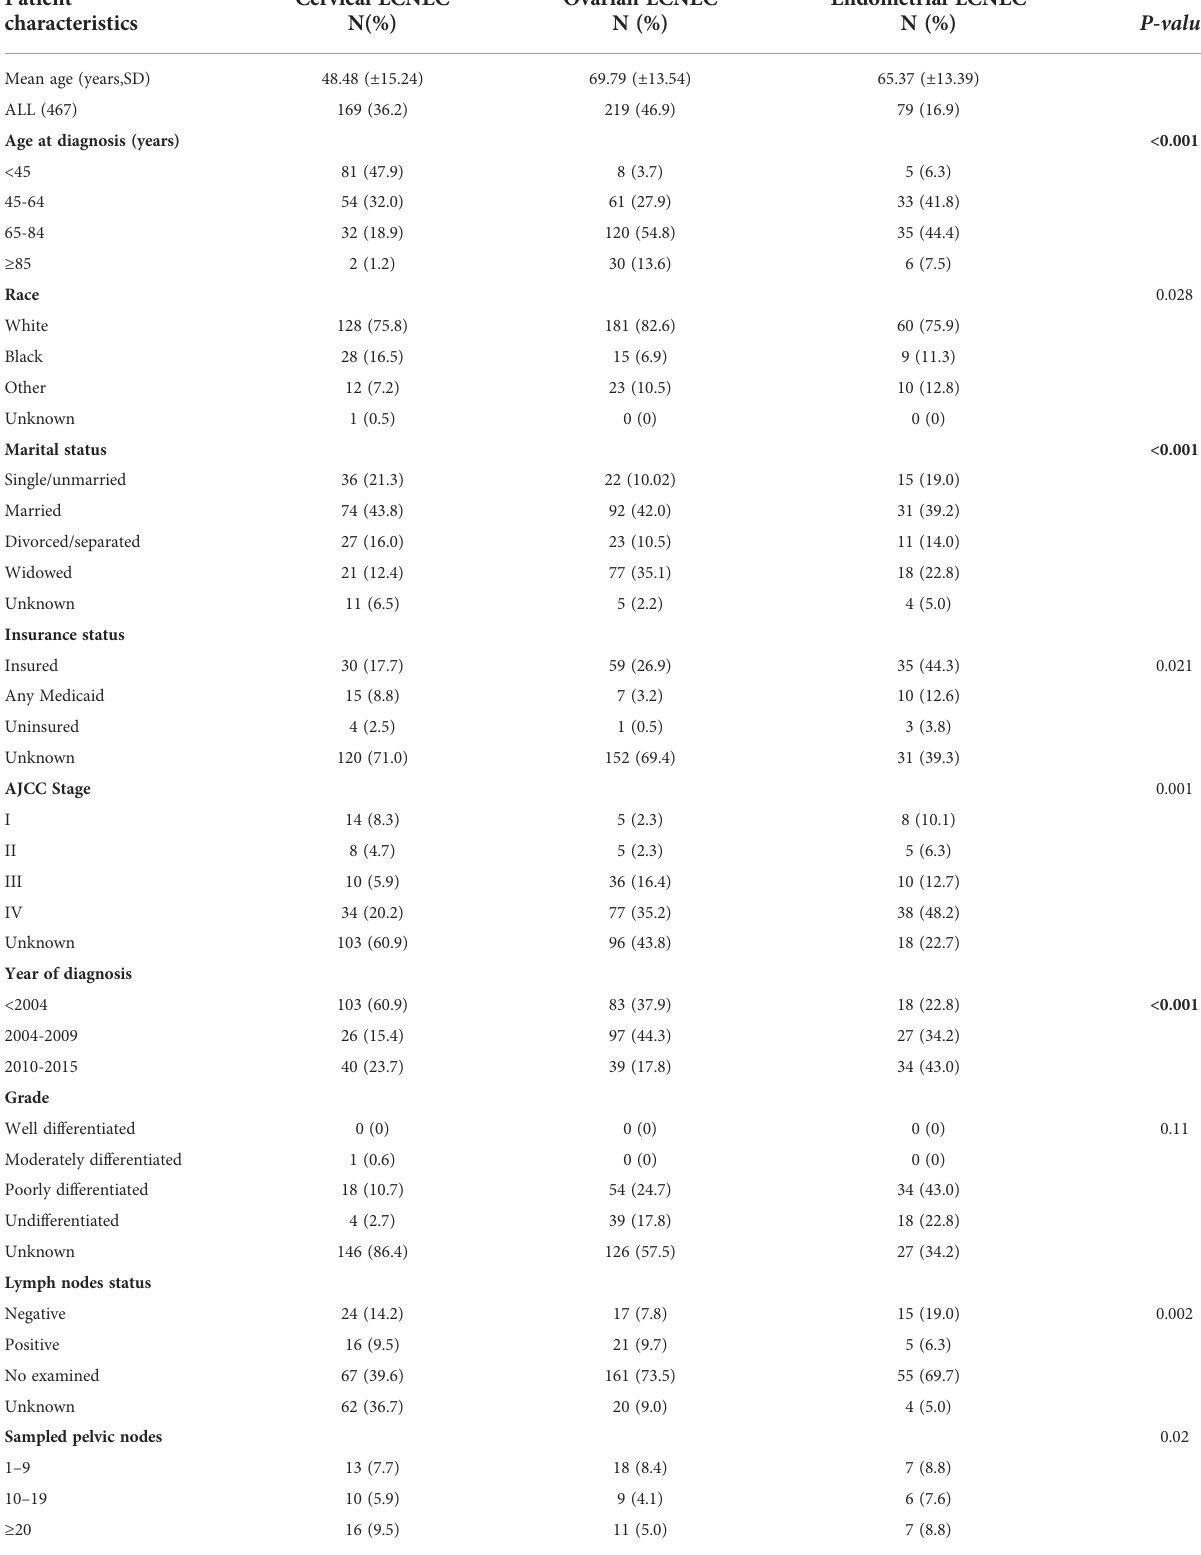
TABLE 1 Demographic and clinical characteristics of patients with gynecologic large-cell neuroendocrine carcinoma